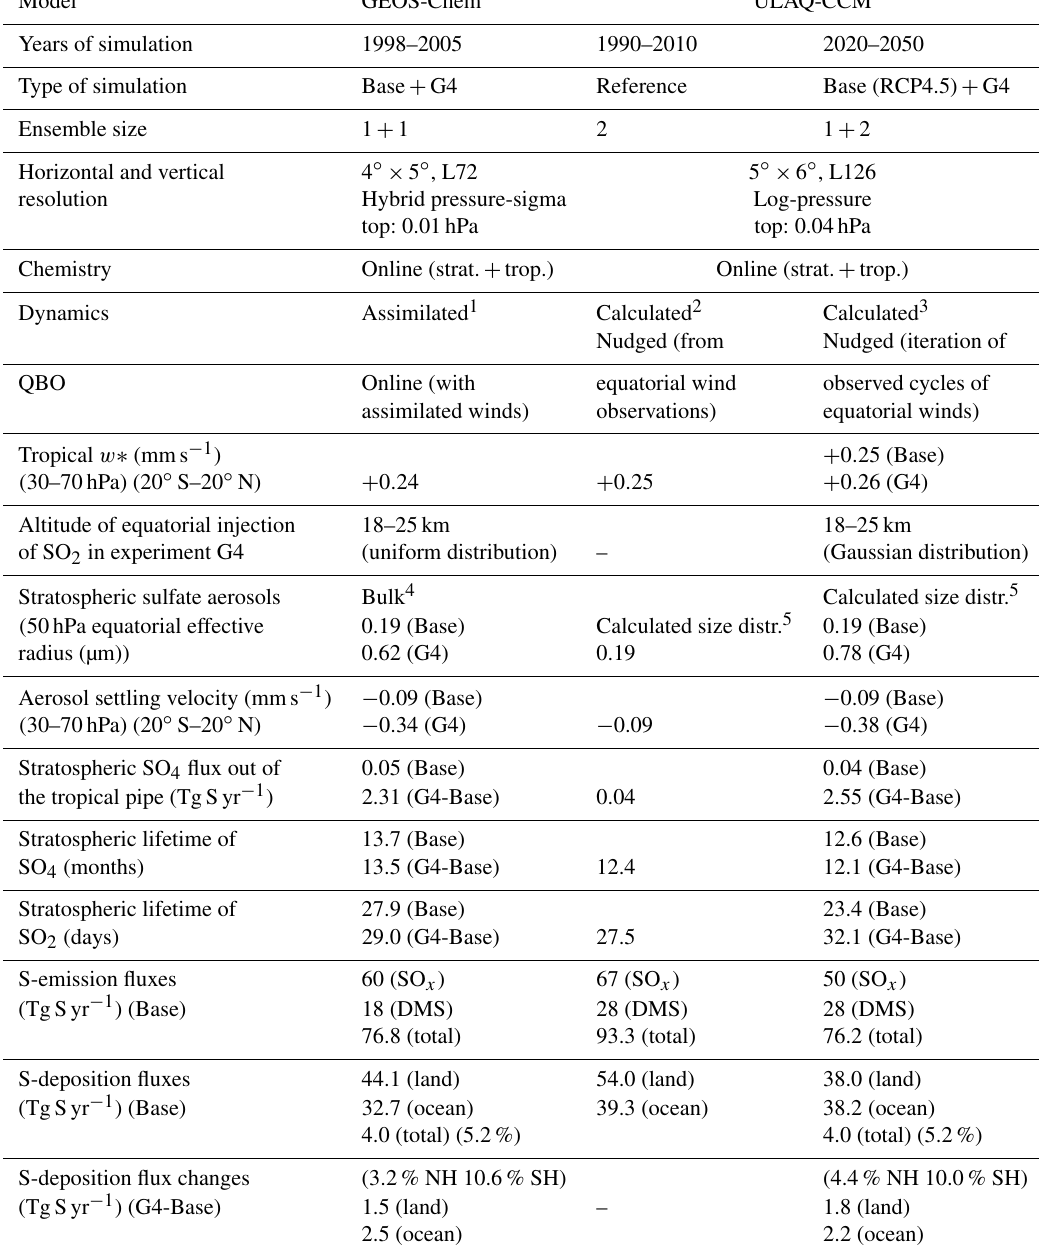
Table 1. Summary of model features in this experiment. Aerosol-related quantities are averaged over the years 2000–2005 in GEOS-Chem and the ULAQ-CCM reference and over the years 2030–2039 for ULAQ-CCM Base (RCP4.5) and G4 simulations. NH: Northern Hemi- sphere; SH: Southern Hemisphere; MERRA: Modern-Era Retrospective analysis for Research and Applications; DMS: dimethyl